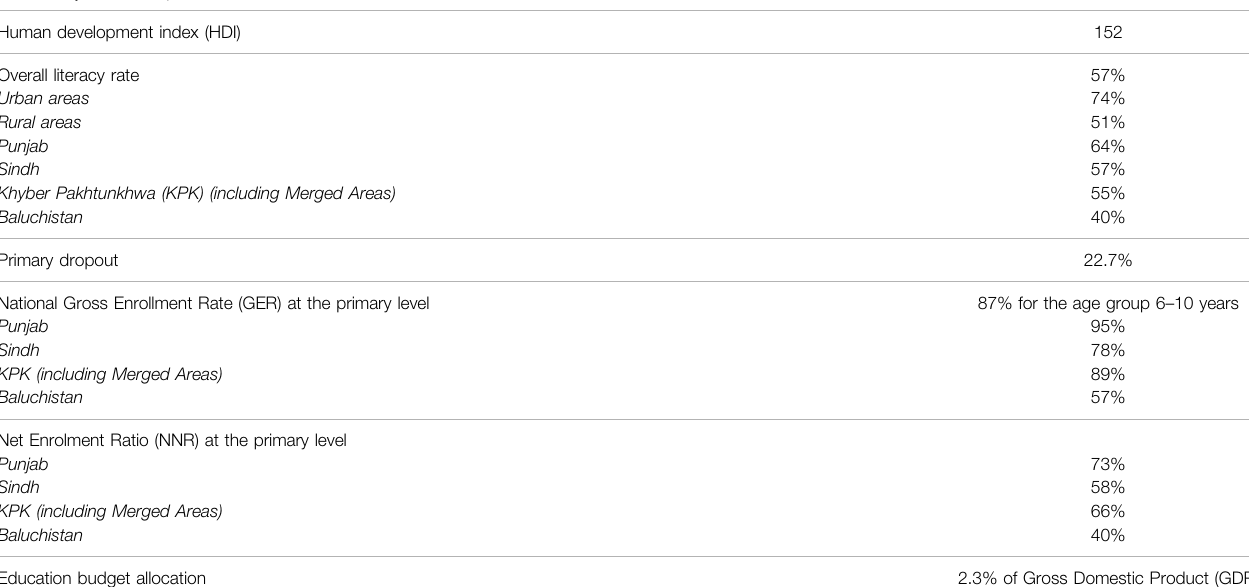
TABLE 1 | Pakistan ’ s pro fi